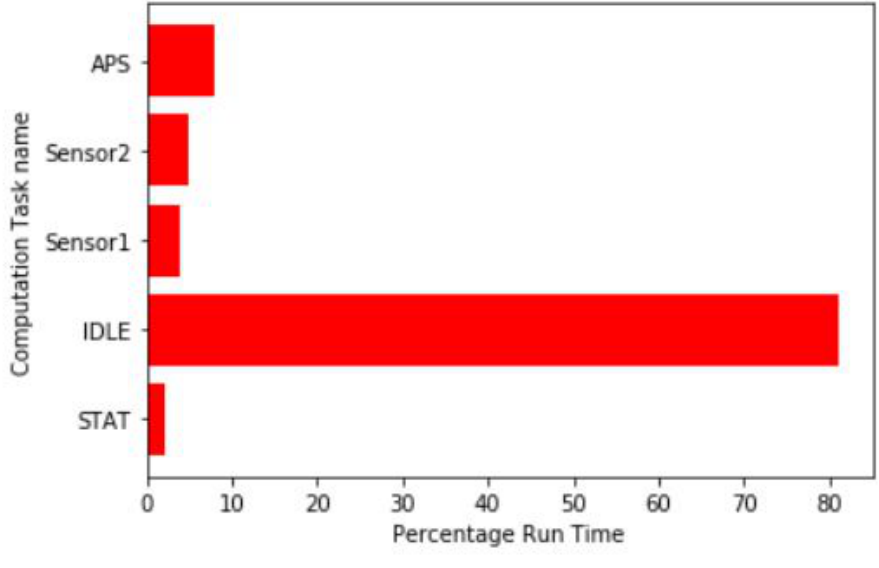
Figure 22. Computation task processor utilization.